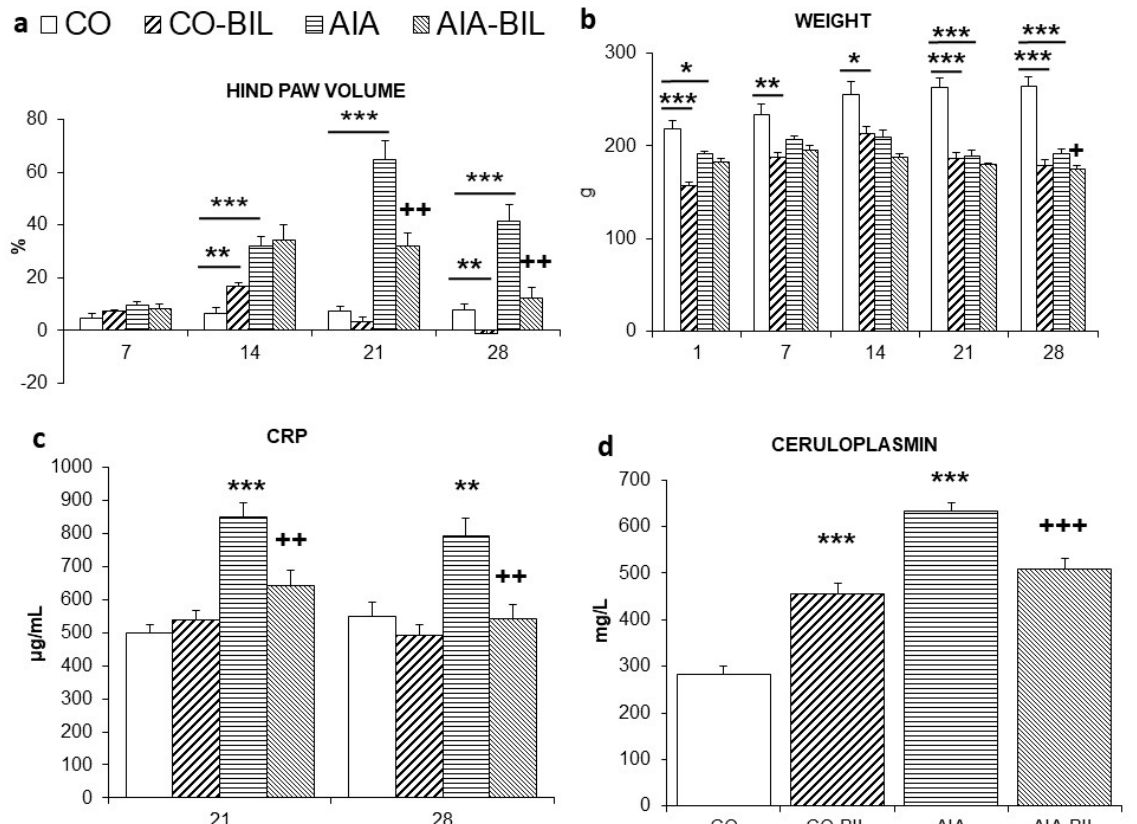
Figure 1. ( a ). Time profile of hind paw volume changes during the course of the experiment. ( b ). Body weight changes of the animals during the experiment. ( c ). CRP levels change on 21st and 28th day and ( d ). Ceruloplasmin levels at the end of the experiment. CO—control group, CO ‐ BIL—control group administered with UCB 200 mg/kg of body weight daily i.p. from day 14, AIA—group with adjuvant induced arthritis, AIA ‐ BIL—group with adjuvant induced arthritis administered with UCB 200 mg/kg of body weight daily i.p. from day 14. Results are expressed as mean ± SEM, n = 7–8. Significant difference between groups CO and CO ‐ BIL, CO and AIA: *** p < 0.001 vs. CO, ** p <0.01 vs. CO, * p < 0.05 vs. CO. Significant difference between groups AIA and AIA ‐ BIL: +++ p < 0.001 vs. AIA, ++ p < 0.01 vs. AIA, + p < 0.05 vs. AIA.